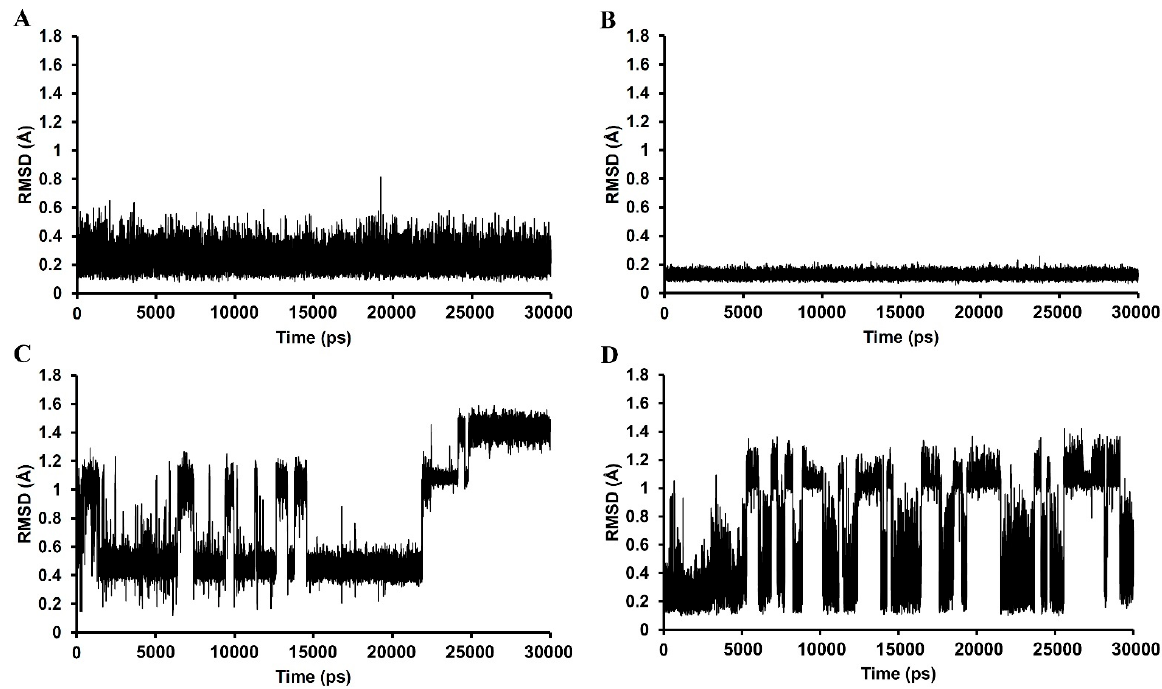
Figure 6. RMSD plots all over the 30,000 ps simulation of the ligand coordinates from the ( A ) methyl eugenol, ( B ) 1,8-cineole, ( C ) 4-allylphenyl acetate, and ( D ) diazepam models.